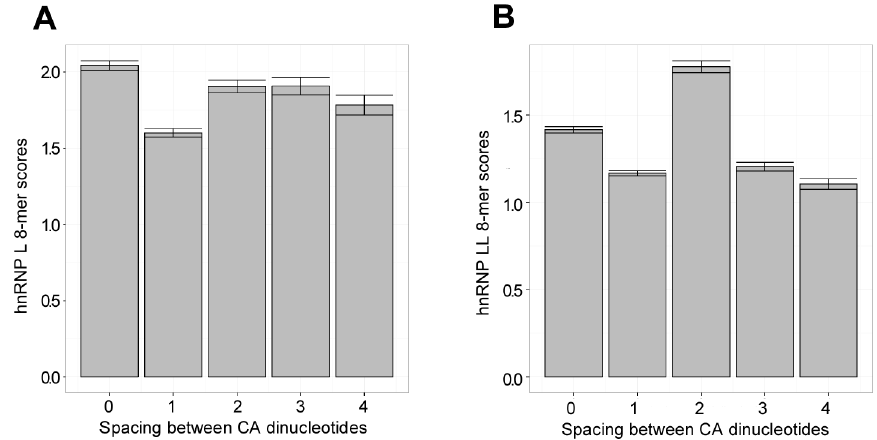
Figure 4. Complete RNAcompete data shows a hnRNP LL-specific preference for a two nucleotide spacer between CA dinucleotides. A bargraph for hnRNP L (A) and hnRNP LL (B) showing the mean Z-score for each possible spacing of 0 to 4 between two CA dinucleotides. Means were calculated for all 8-mers within the RNAcompete dataset that contain the sequence CA[N ]CA. Error bars show the standard error. 0-4 doi: